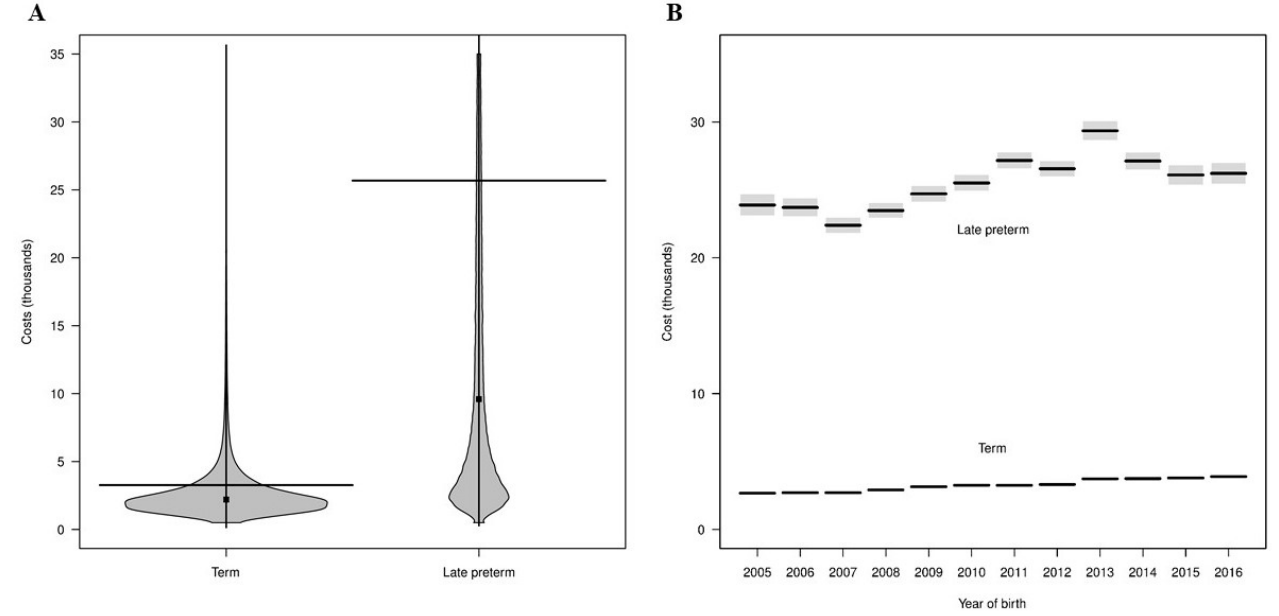
Figure 2. Healthcare costs of birth hospitalization. Panel ( A ) displays a bean plot of distributions of total birth hospitalization costs for term and late preterm infants. The horizontal line indicates the mean value and the dot indicates the median value. Costs greater than 35,000 USD are not displayed. Panel ( B ) displays estimated mean birth hospitalization costs from 2005–2016 from a fitted regression model. Estimated mean costs are indicated by black lines and 95% confidence intervals by gray regions. Gray regions are not observed for term infants because the confidence intervals are very narrow around the mean estimates.